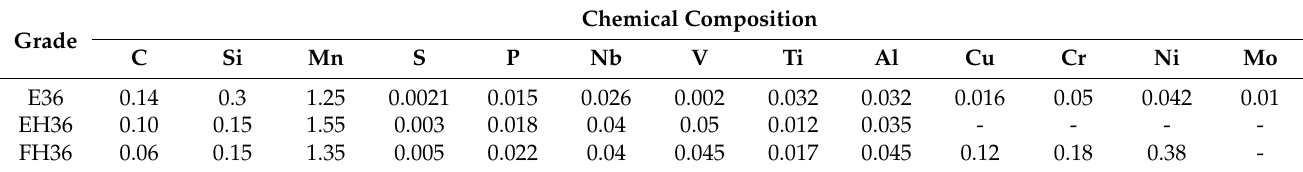
Table 1. Chemical composition of the three grades of ship plate steel (mass fraction, %). Chemical